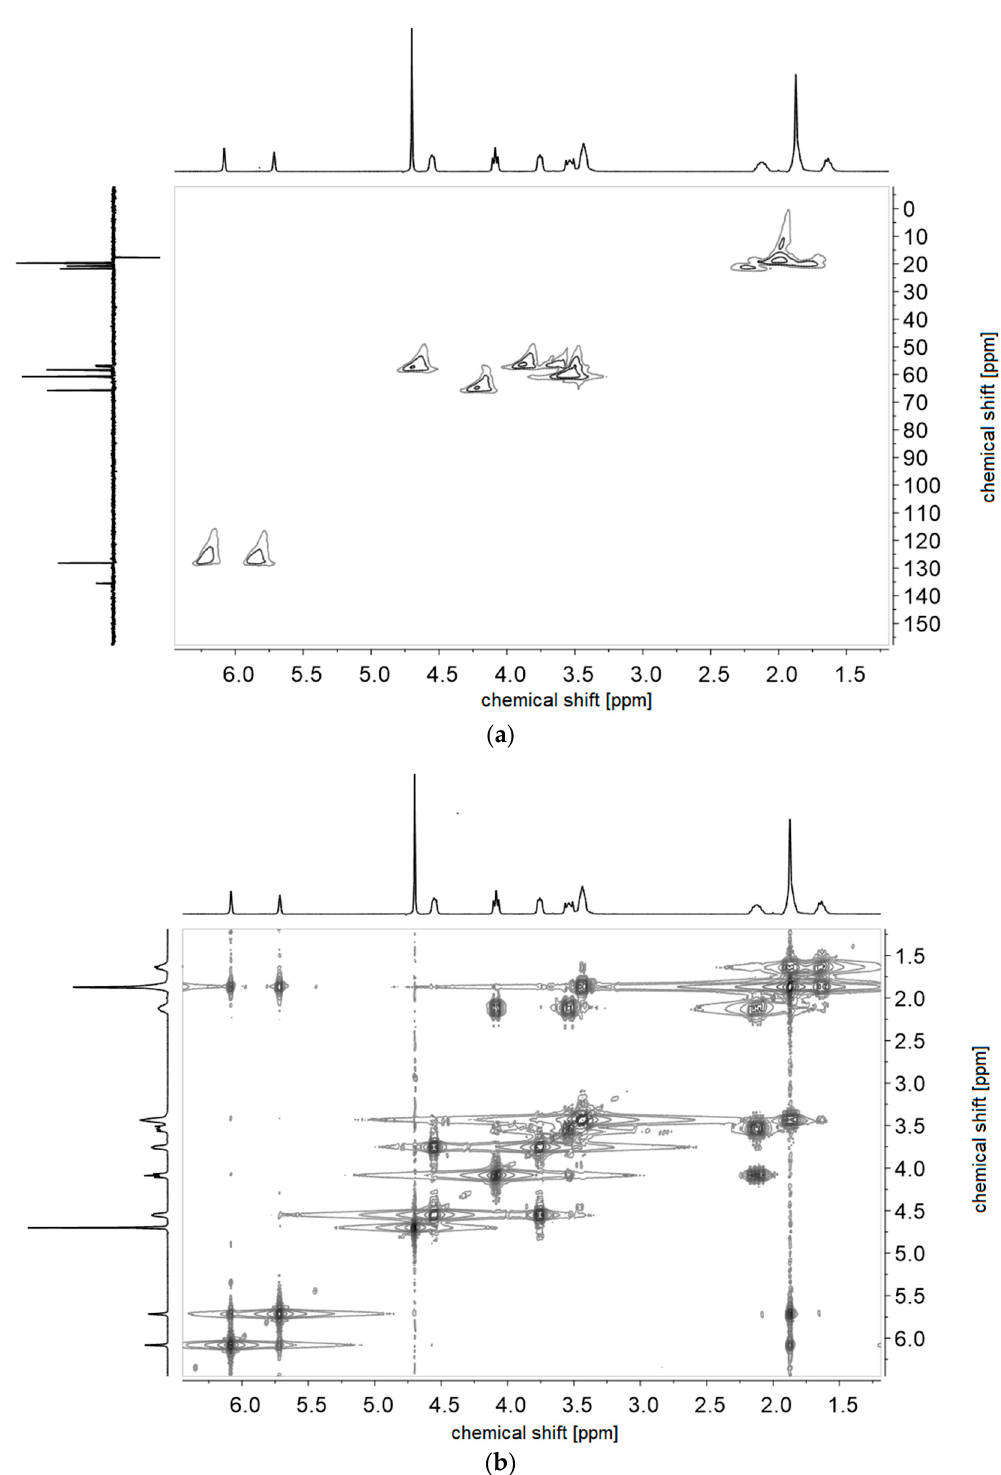
Figure A8. ( a ) 1 H- 1 H-COSY- and ( b ) 1 H- 13 C-HMQC NMR-spectra of monomer of 4d in D 2 O.